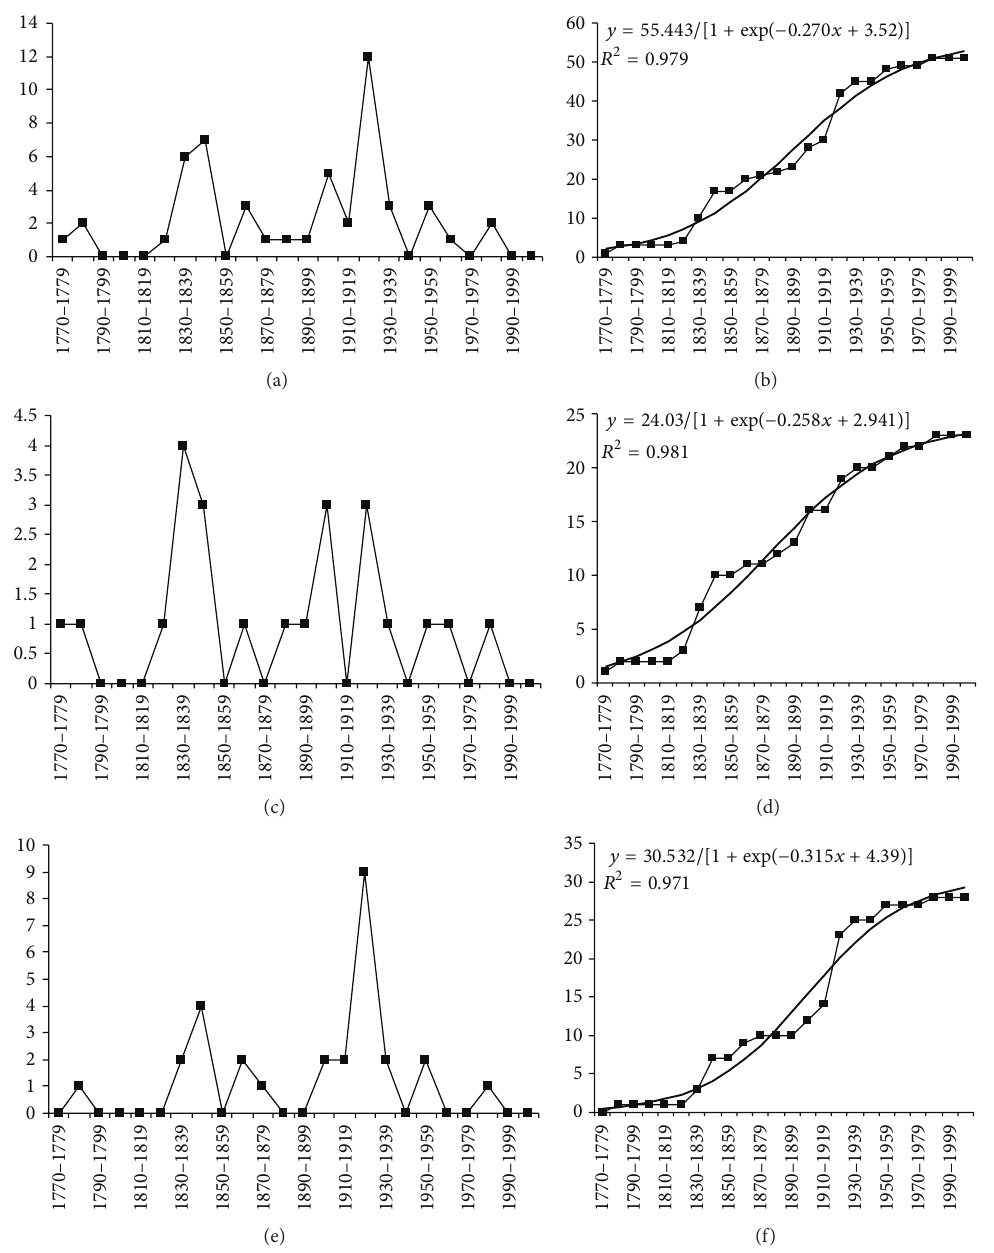
Figure 6: Numbers of total described genera (a, b), valid genera (c, d), and synonyms (e, f) of Paussini by decade. Figures (a), (c), and (e) report the absolute numbers, and Figures (b), (d), and (f) the cumulative numbers along with the equations of the fitted curves.